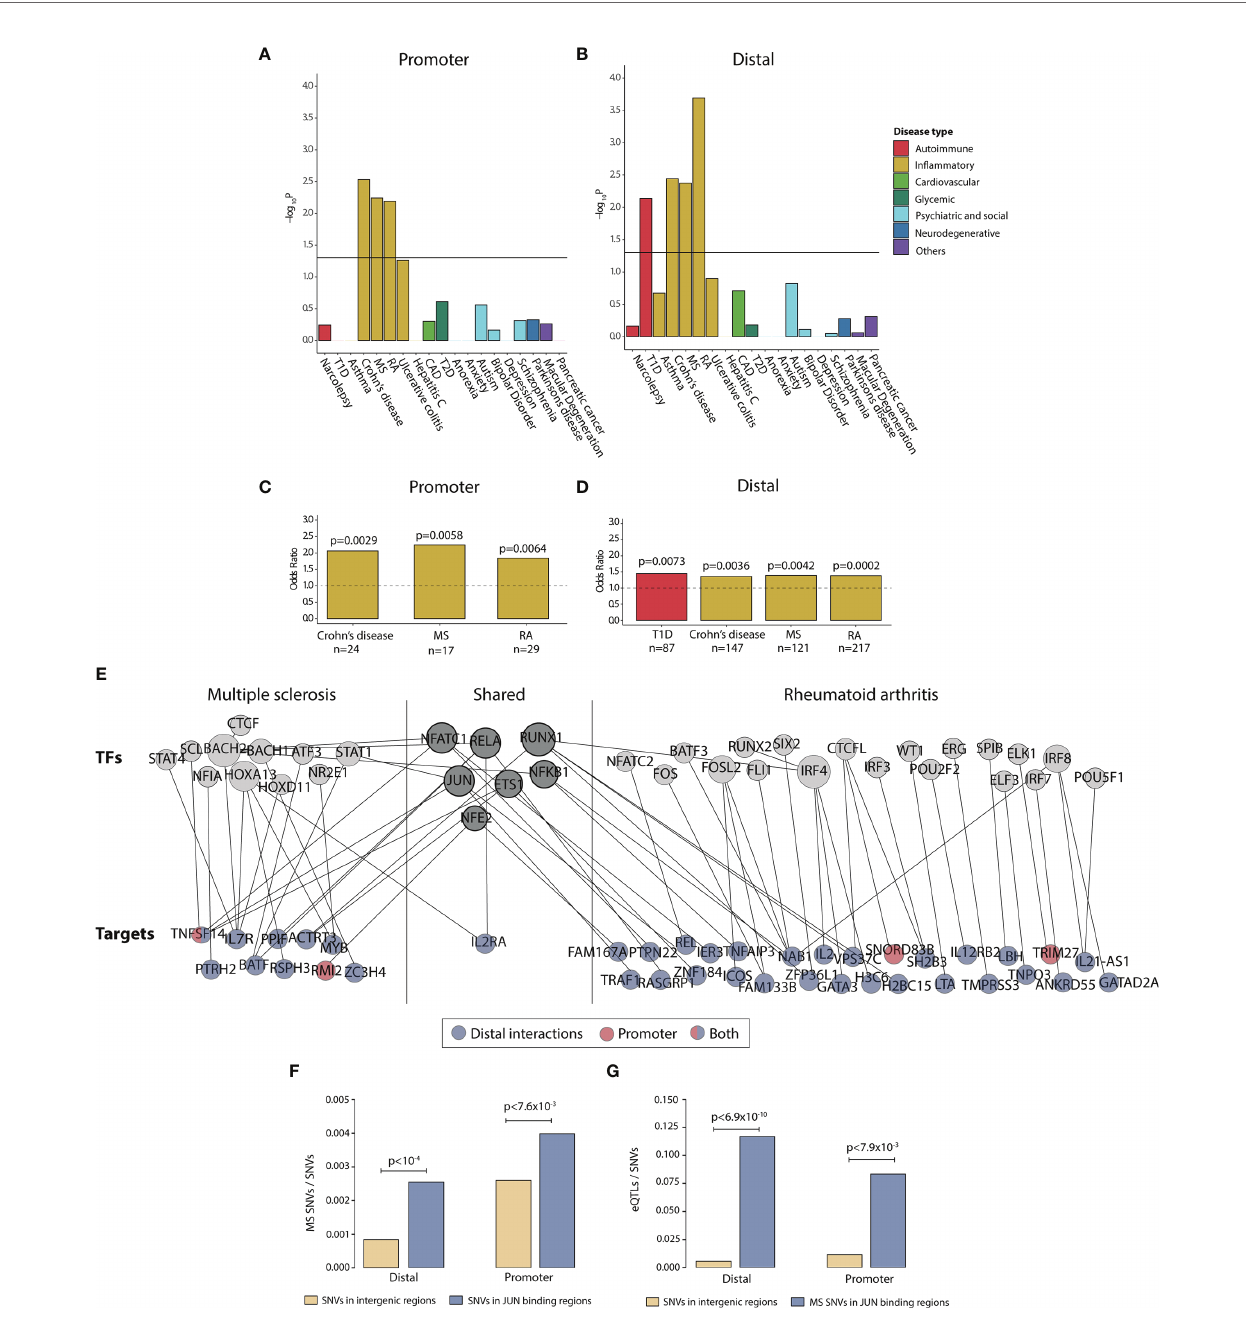
FIGURE 4 | Progesterone downregulates disease-associated genes in immune-mediated diseases. Enrichment of disease SNP-associated genes in the promoter and distal peaks that were overlapping between peaks upregulated during T H 1 differentiation and downregulated with P4. (A, B) -log 10 p values for disease enrichment in the overlapping promoter and distal peaks. The promoter and distal peaks were combined over the whole time series. Disease enrichment was performed with Fisher ’ s exact test where a p-value of <0.05 was considering statistically signi fi cant. (C, D) Odds ratio for enrichment of SNP-associated peaks in Crohn ’ s disease, MS, RA and Type 1 diabetes with the number of overlapping genes (annotated from the SNPs) are denoted below. (E) Network of the genes and TFs present in the overlapping promoter and distal peaks for MS and RA. Shared TFs and genes are present in both diseases. The target genes have been colored based on if the gene is associated to the promoter peaks (red), distal peaks (blue) or both (blue and red). Some of the genes were denoted both as TFs and targets. (F) Proportion of MS-associated SNPs among common SNVs in intergenic regions compared to JUN binding sites, both for the distal and promoter regions. Statistical differences were determined using permutation test (10,000 permutations). (G) Proportion of eQTLs among SNVs in intergenic regions compared to proportion of eQTLs among MS-associated SNPs in JUN binding sites, both for the distal and promoter regions. Fisher ’ s exact test was used to determine statistical differences. CAD, coronary artery disease; MS, multiple sclerosis; RA, rheumatoid arthritis; SNP, single nucleotide polymorphism; SNV, single nucleotide variant.; eQTL, expression quantitative trait locus; T1D, Type 1 diabetes; T2D, Type 2 diabetes; TF, transcription factor; T H 1, T helper 1